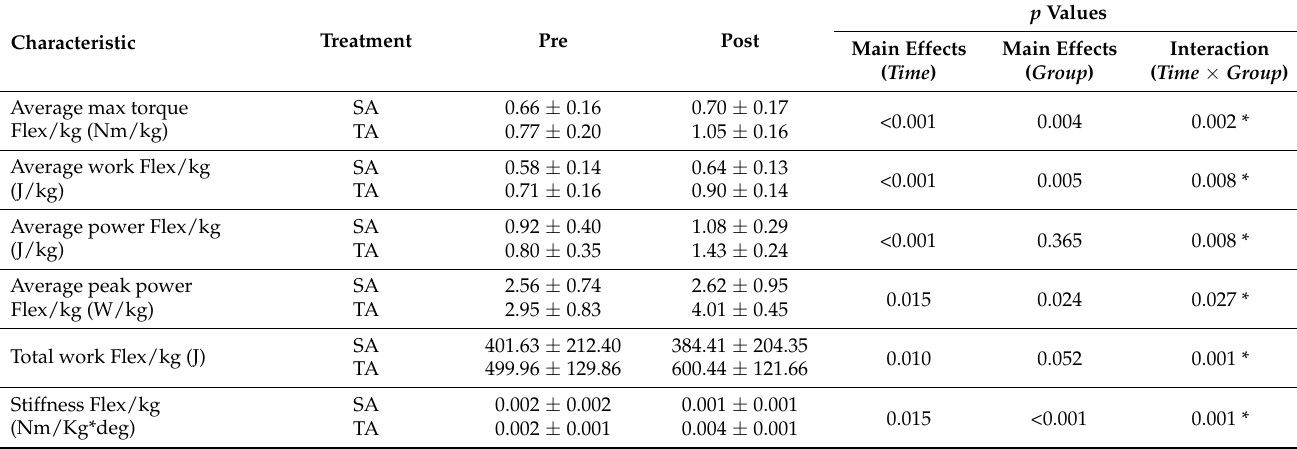
Table 1. Mean ± SD of each variable for knee flexion (Flex) before and after acupuncture in TA and SA group. Characteristic Treatment Pre Post